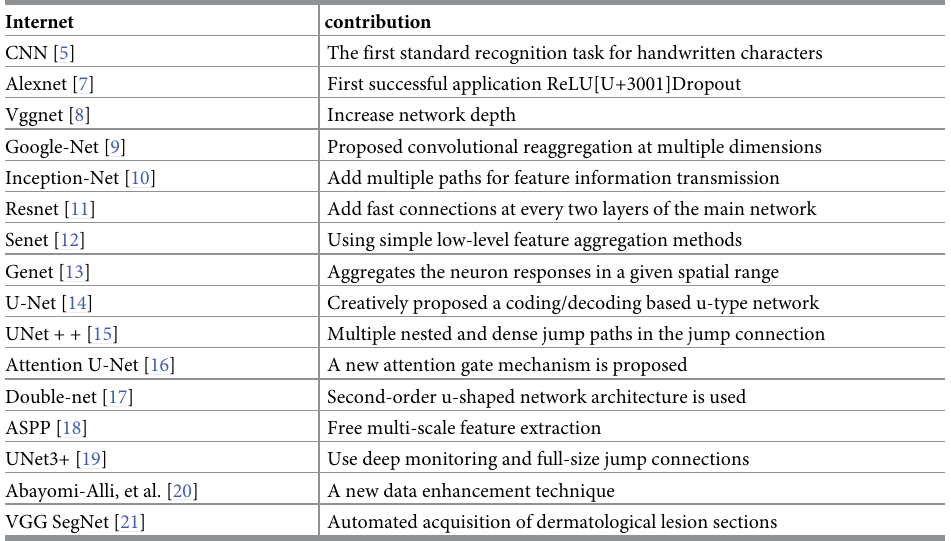
Table 1. The contributions of CNN